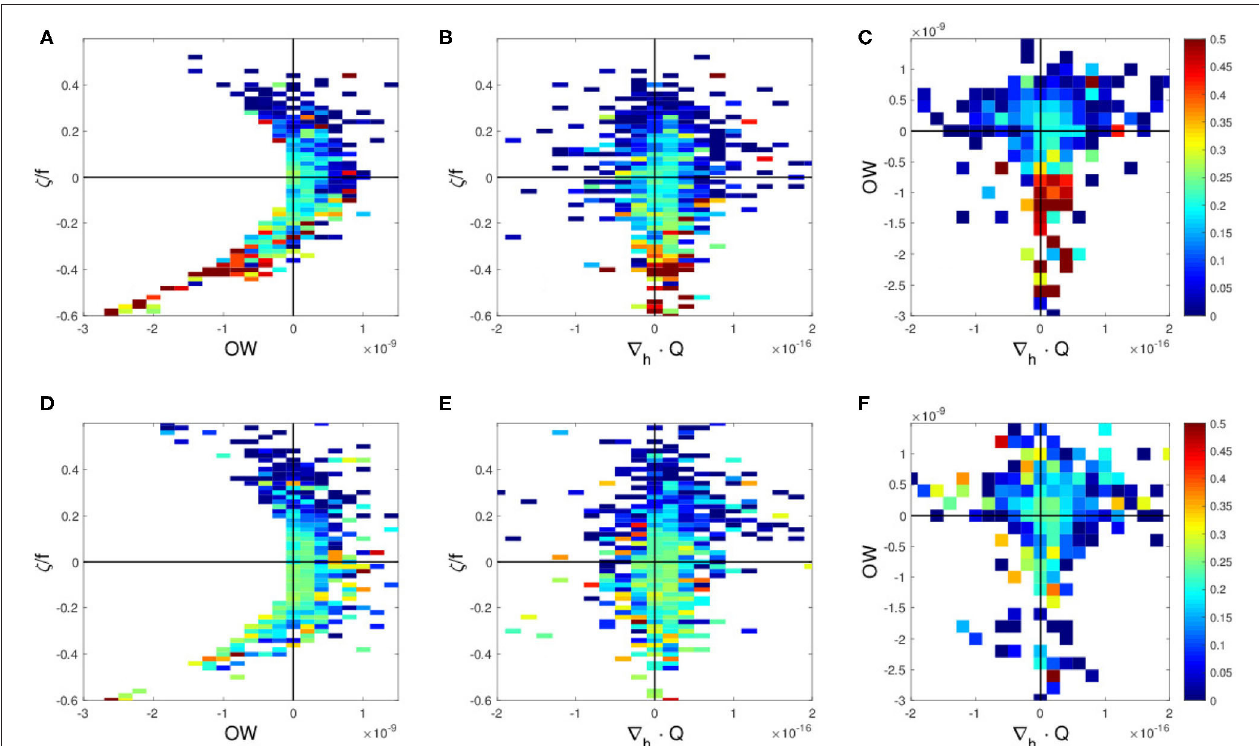
FIGURE 5 | Swordfish CPUE during the unstable period 2006–2009 as a function of (A,D) Okubo-Weiss (OW) parameter (2) and vorticity (3) normalized by f Coriolis parameter, ζ/ f , (B,E) divergence of Q-vector, ∇ h · Q (4) and normalized vorticity ζ/ f , and (C,F) divergence of Q-vector and OW for (A–C) the northern region 36–45 ◦ N, and for (D–F) the southern region 25–36 ◦